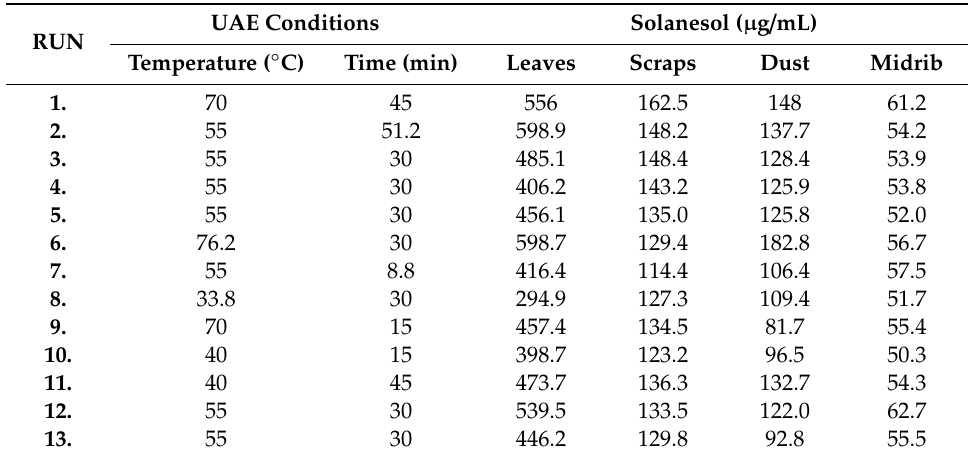
Table 3. Solanesol content in tobacco extracts.